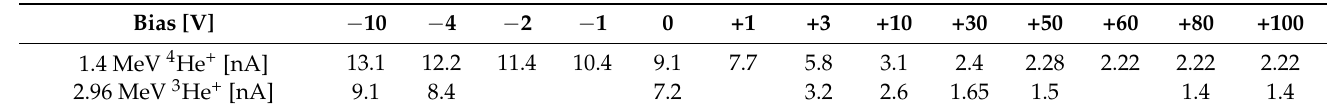
Table 2. Measured sample current for two different ion beam settings on different materials. In both cases, the current increases with negative and decreases with positive biasing of the sample holder. At around +80 V bias, the secondary electrons seem to be completely suppressed in both